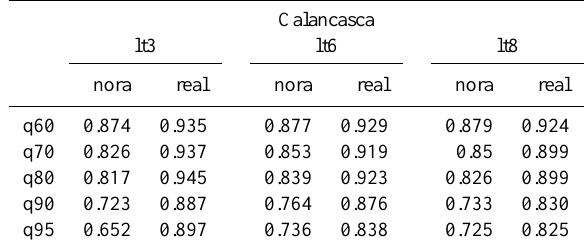
Table 2. ROC area for NORA and REAL-C2 forecasts of the Calan- casca Catchment, with lead times 03:00, 06:00 and 08:00, for the threshold quantiles q60 to q95.